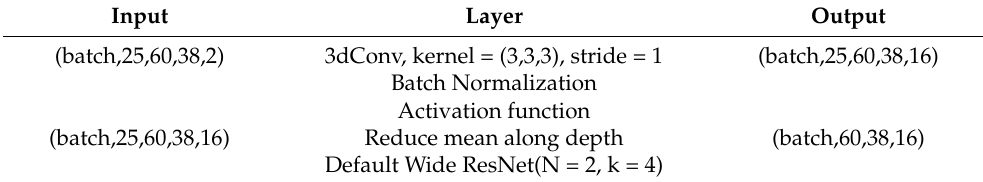
Table 4. Integrated framework of 3D convolution structure and the original network.